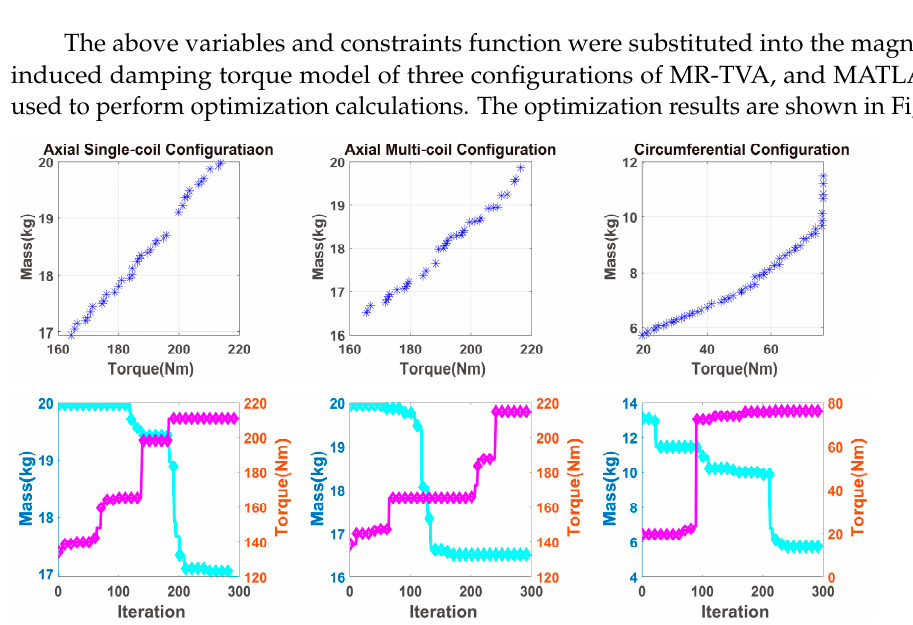
Figure 15. The optimized iteration results of the mass and damping torque of MR-TVA. As shown in Figure 15, the blue asterisk in the figure represents the final selectable mass and torque after multiple iterations, while the blue line in the figure represents the iterative process of mass and the red line represents the iterative process of torque. From the iterative process, can known the performance characteristics and upside of the three